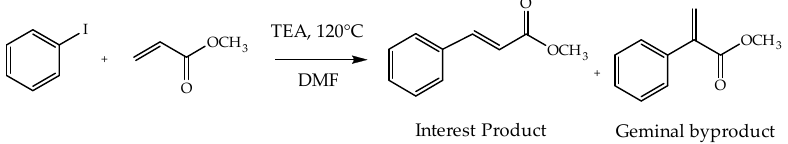
Figure 7. Kinetic profiles for the coupling of I-Ph with methyl acrylate to produce methyl cinnamate (MCIN) using the Pd-based catalysts. ( a ) Open square: Pd(CH 3 CO 2 ) 2 ; open triangle: Pd-SALOPHEN, fill circle: PdAS(1)-MA, fill diamond: PdAS(2)-MA, fill pentagon: PdAS(5)-MA, and fill inverse triangle: PdAS(10)-MA. ( b ) Hg(0) poisoning test for Pd-SALOPHEN catalyst and ( c ) Hg(0) poisoning